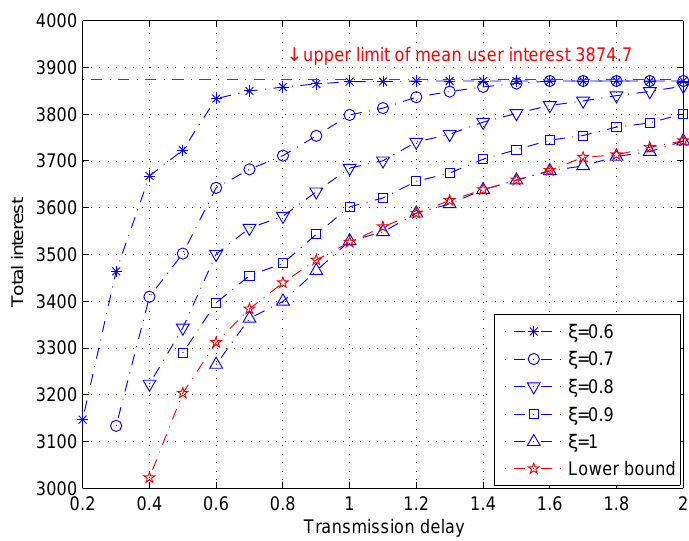
Figure 3. Theoretical bounds and simulation results of the total user interest as a function of the transmission delay with varying outage probability ξ